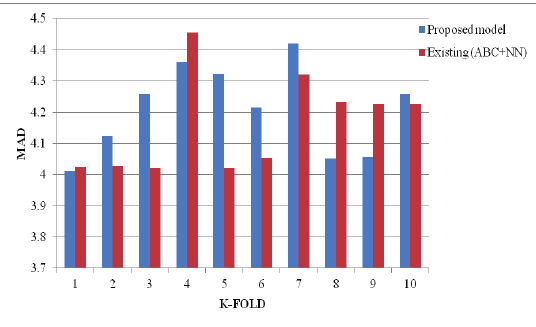
Fig.10. RMSE based Comparision graph of proposed against existing using k-fold cross validation method